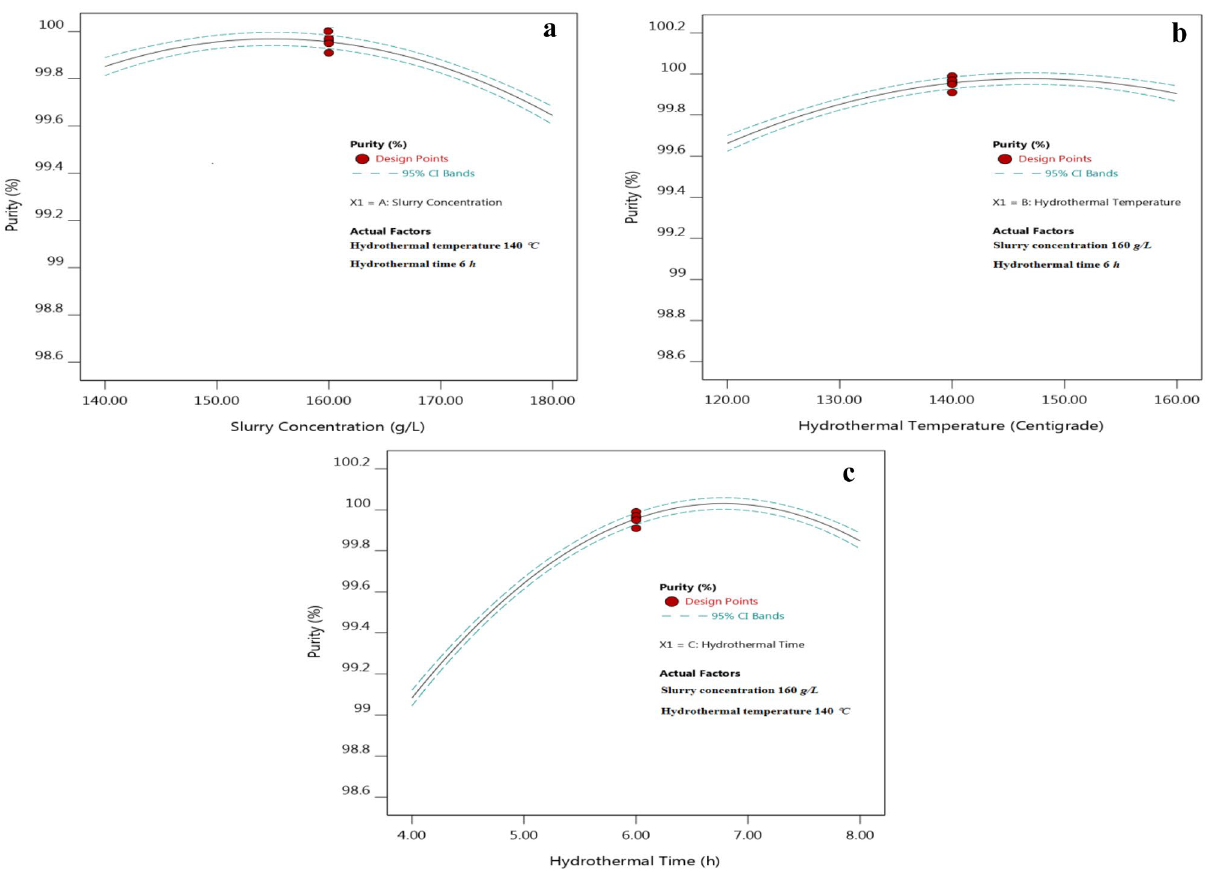
Figure 1. Effects of hydrothermal conditions on the purity of TiO 2 ( a ) Hydrothermal temperature 140 °C, Hydrothermal time 6 h; ( b ) Slurry concentration 160 g/L, Hydrothermal time 6 h; ( c ) Slurry concentration 160 g/L, Hydrothermal temperature 140 °C